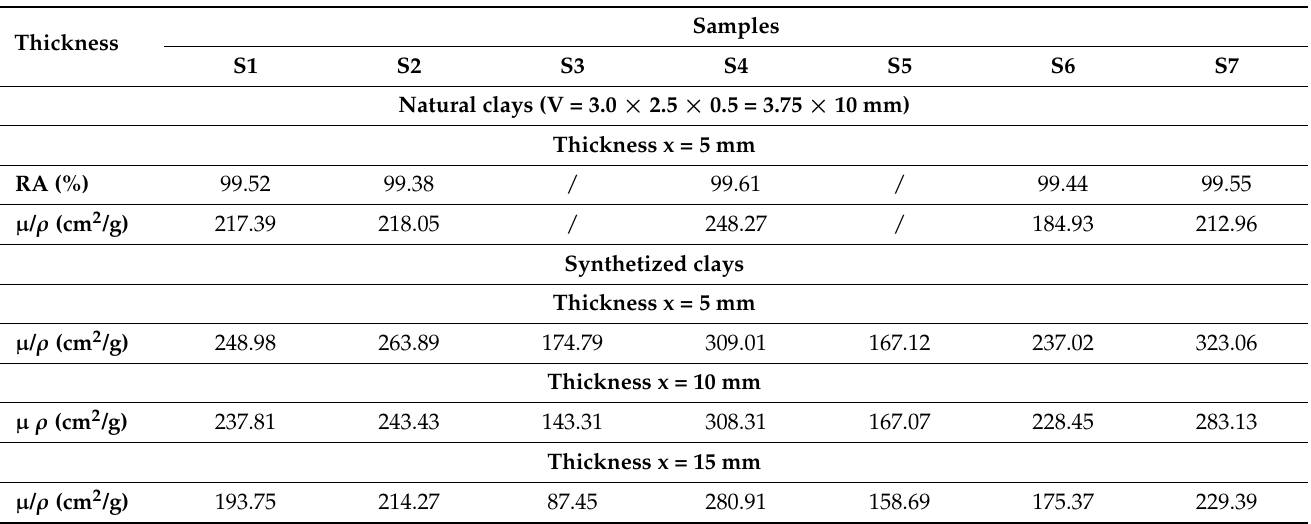
Table 5. Mass absorption coefficient ( µ / ρ ) and radiative attenuation percentages (RA) for natural and synthetized